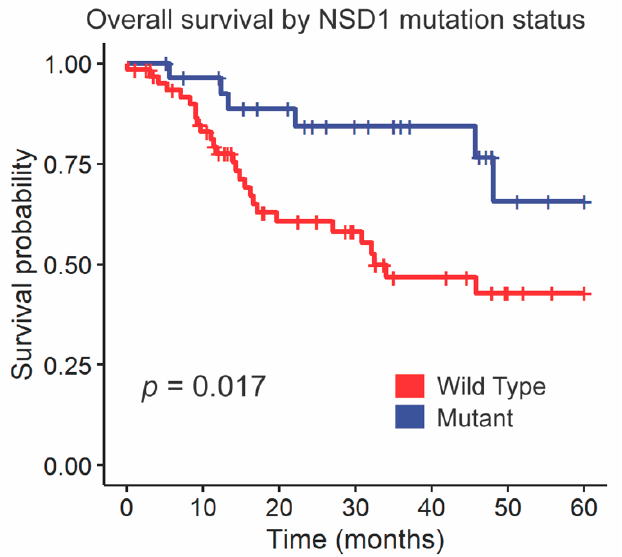
Figure 3. Kaplan-Meier curves for overall survival by NSD1 SNV mutation status. A log-rank test was used to compare the Kaplan-Meier curves between tumors with wild-type and mutant alleles.